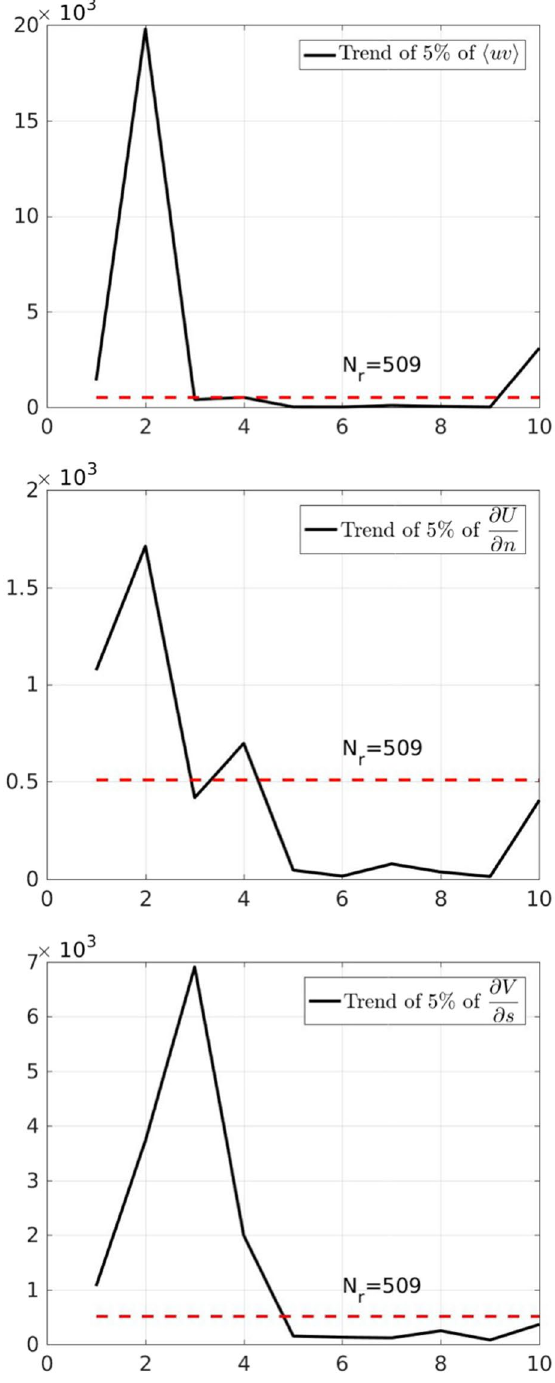
Figure 6. Number of realizations needed to achieve a 5% of the dimensionless error vs representative times. From top to bottom: Reynolds stress, mean simple shear and streamline